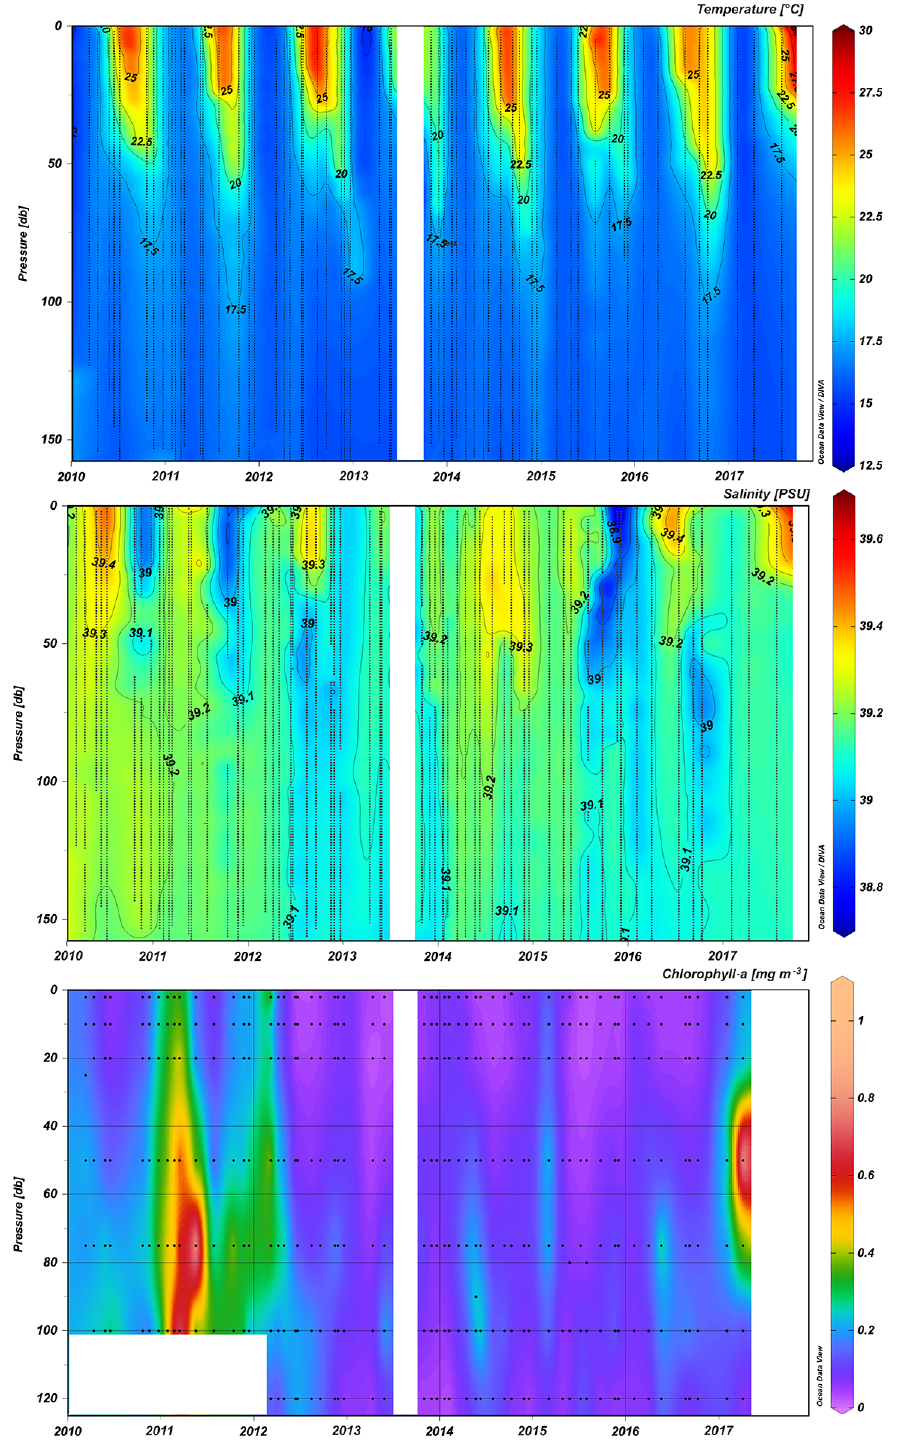
Figure 6. Vertical distribution of temperature, salinity (CTD casts) and total Chl- a (fluorometric analysis of seawater from bottle sampling) from 2010 to 2017 at the POSEIDON E1-M3A